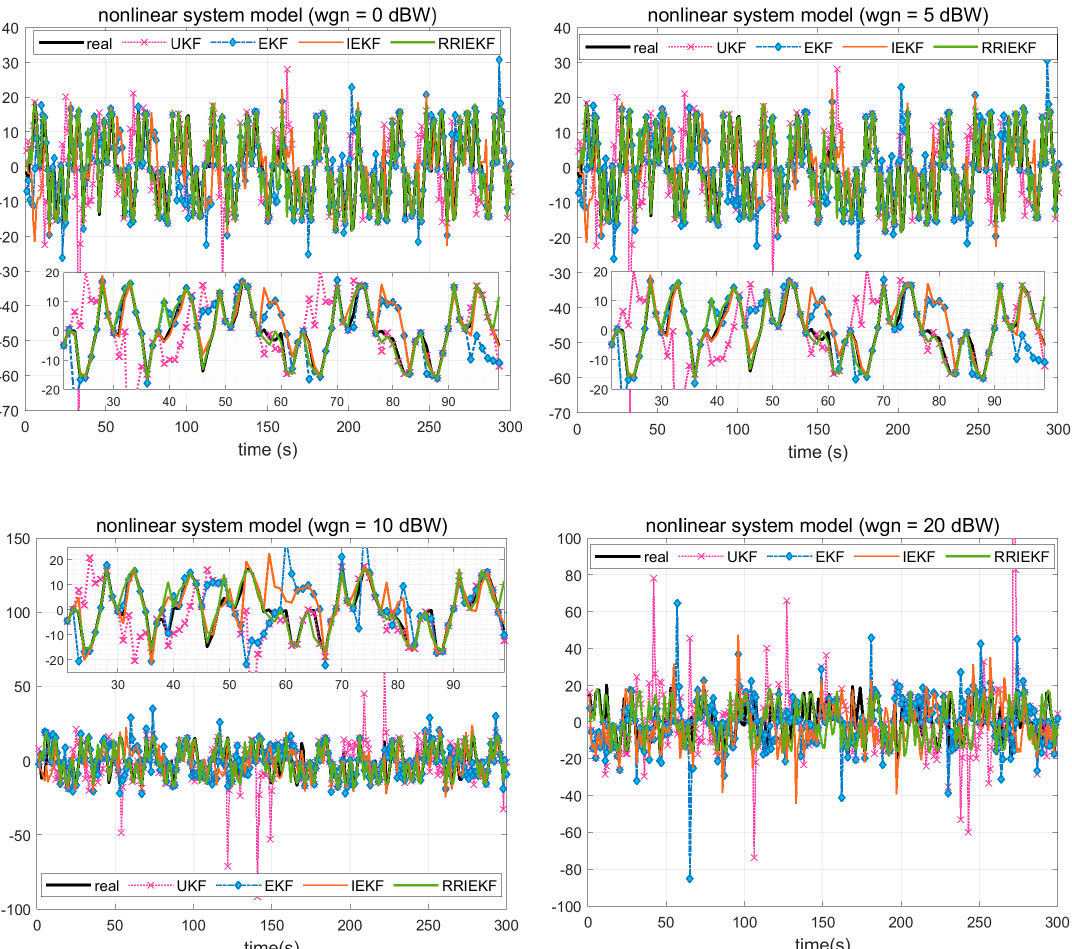
Figure 5. Performance over complexity.